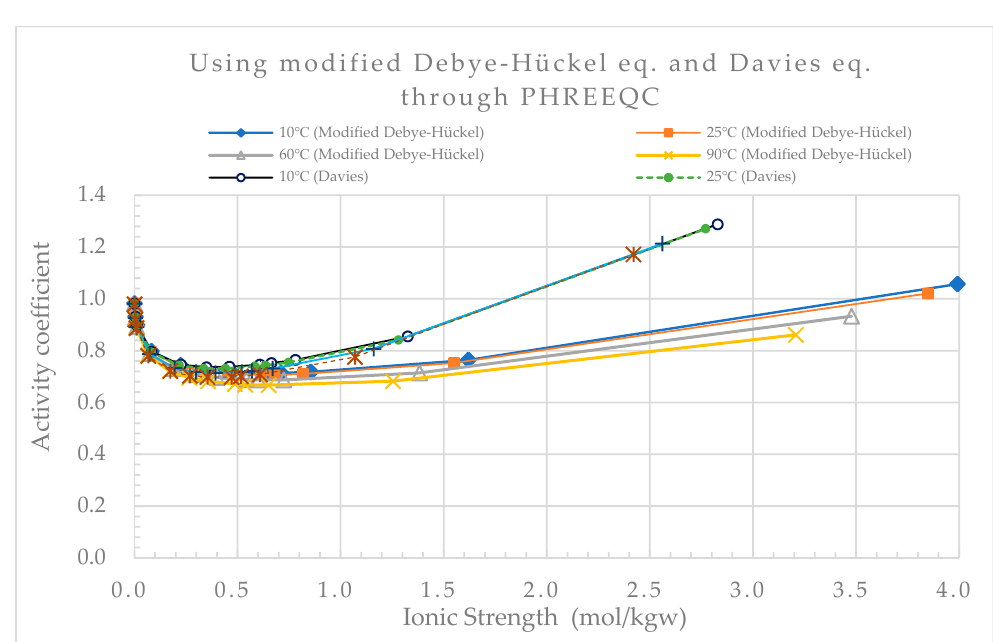
Figure 15. Dependence of the activity coefficient of Na + on the ionic strength for different temperatures through PHREEQC.